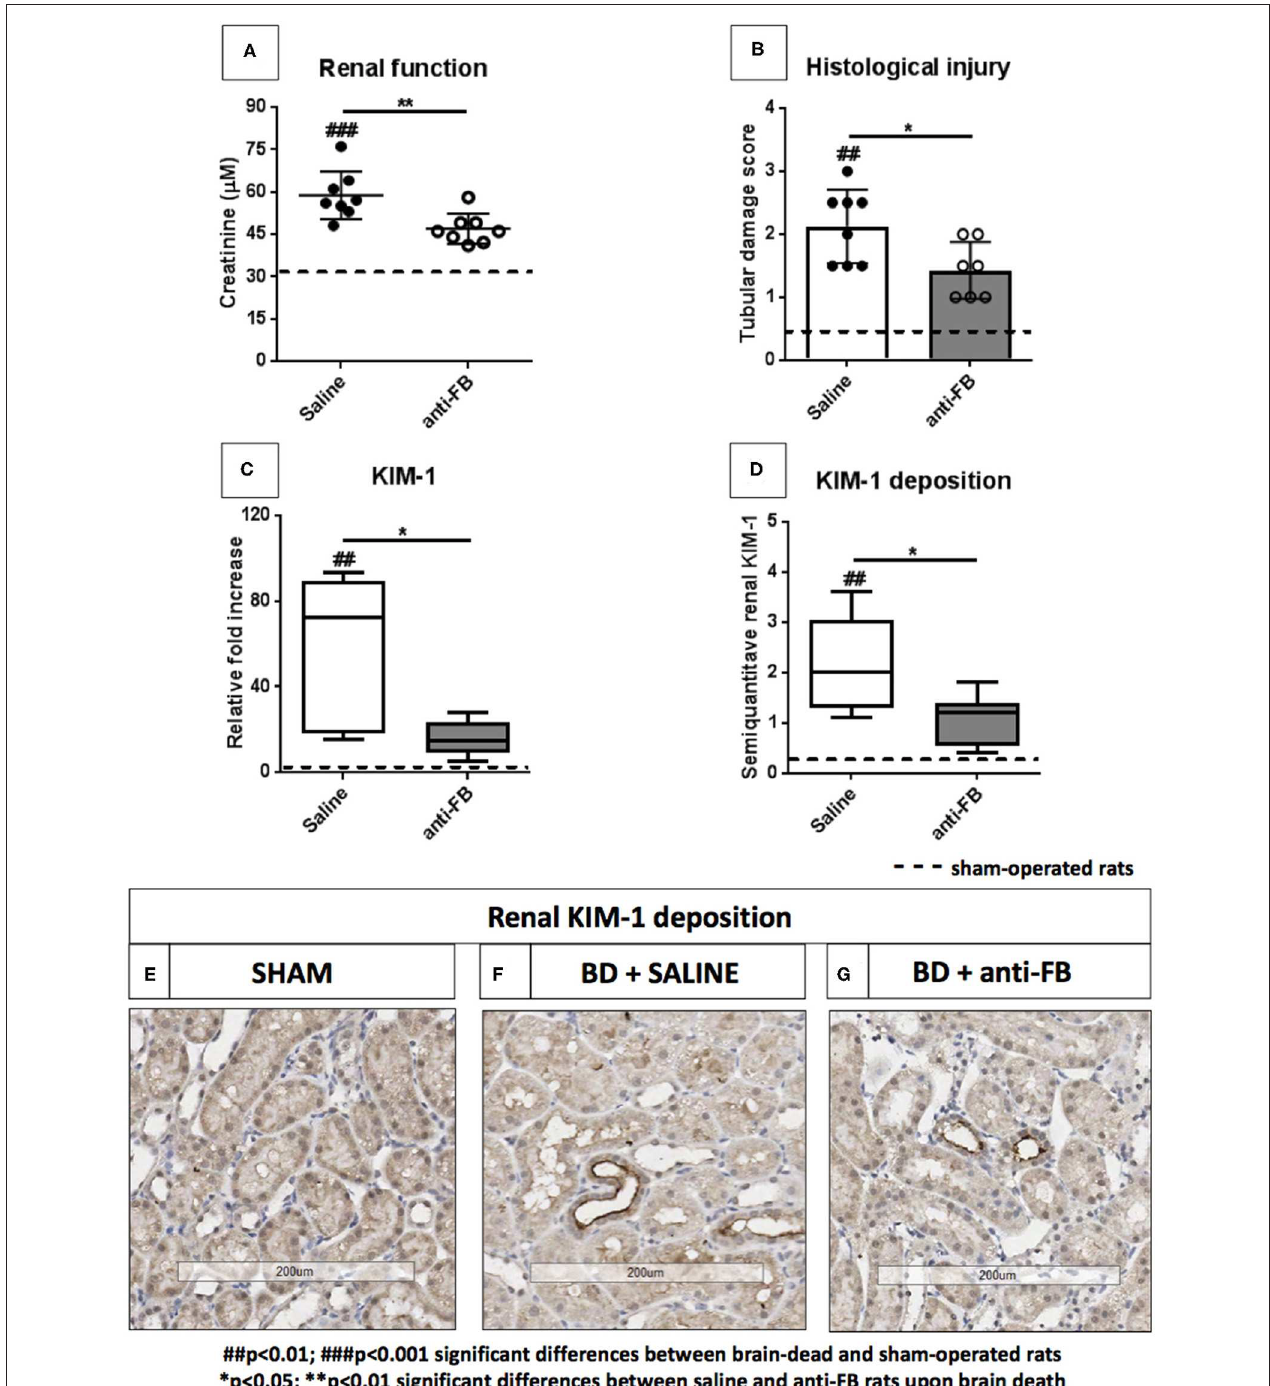
FIGURE 3 | Renal function and renal injury upon brain death with saline or anti-factor B. (A) Renal function reflected by plasma creatinine levels of brain-dead rats treated with saline or anti-FB compared to sham-operated rats. Serum creatinine levels were measured at time of sacrifice, using a Roche Modular P system. (B) Tubular damage was reflected as a percentage of acute tubular necrosis in the renal cortex using a semi-quantitative method. (C) Renal KIM-1 gene expression in brain-dead and sham-operated rats treated with saline or anti-FB was determined by quantitative real-time PCR. The mRNA expression of KIM-1 relative to β -actin was set at 1 in sham-operated rats, the other values, are calculated accordingly. (D) Renal KIM-1 deposition after 4h of brain death, KIM-1 was scored by estimating the percentage of KIM-1 expression in the cortical tubules. (E) KIM-1 deposition in sham-operated rats, (F) in saline-treated rats, and (G) anti-FB treated rats. Data are shown as median ± IQR. Data were analyzed by Mann Whitney- U -test and Bonferroni post-hoc test, asterisks above the bars denote significant differences between the brain-dead rats (* p < 0.05, ** p < 0.01, and *** p < 0.001). The dashed line represents the mean of the sham-operated rats. # Significant differences between the brain-dead rats vs. sham-operated rats ( # p < 0.05, ## p < 0.01, and ### p < 0.001). Anti-FB, anti-factor B.